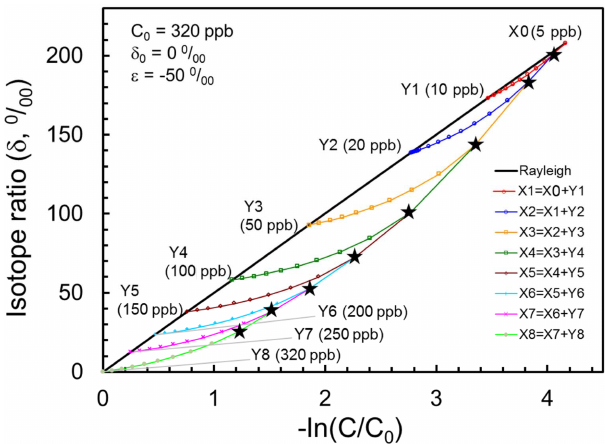
Figure 7. Presentation of X i (black stars) obtained using the mixing model with assumed Y i in the Rayleigh plot. The straight line shows tropical vertical isotopocule fractionation without transport/mixing effect. Curves show mixing between X i − 1 and Y i , where mixing ratio Y i /X i is assumed to be